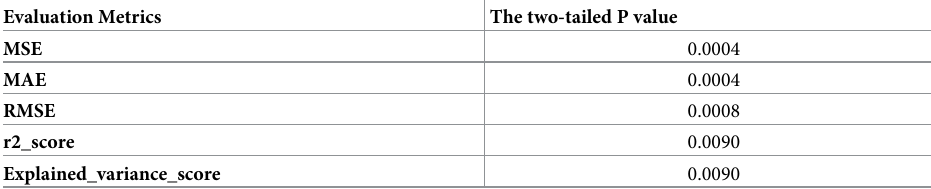
Table 8. This table shows the two-tailed p-values. Evaluation